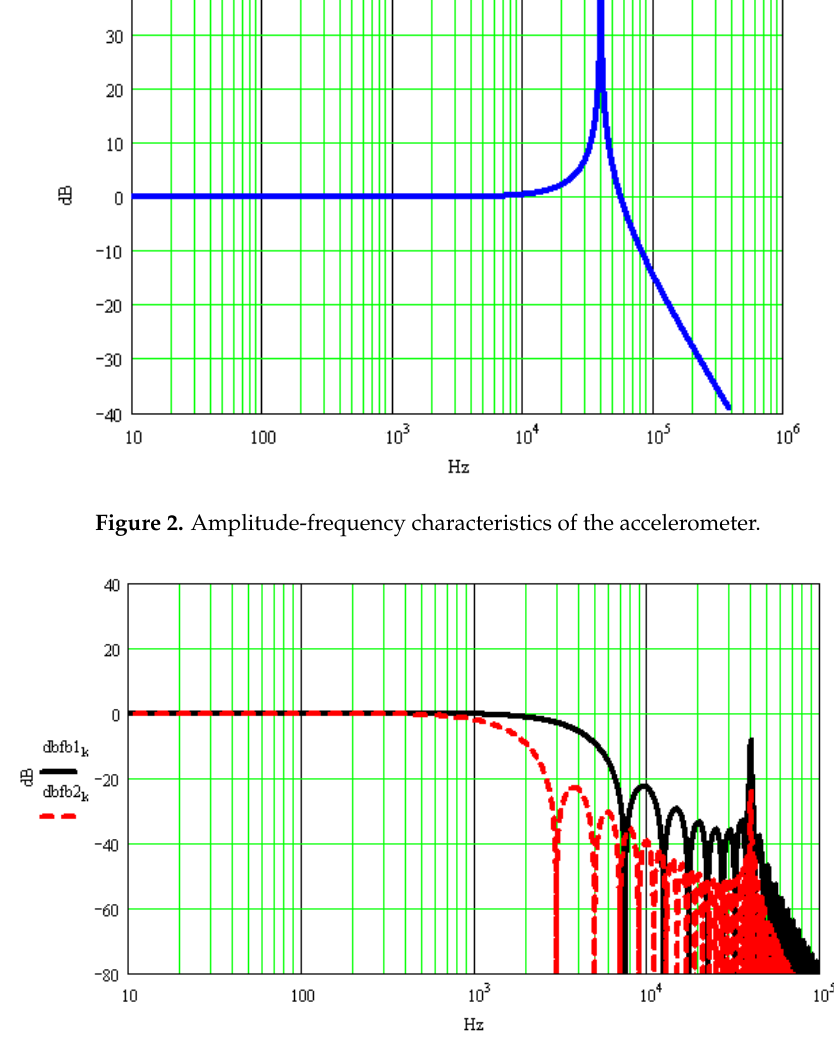
Figure 3. Sensor’s frequency domain response to the two pulsed excitations.